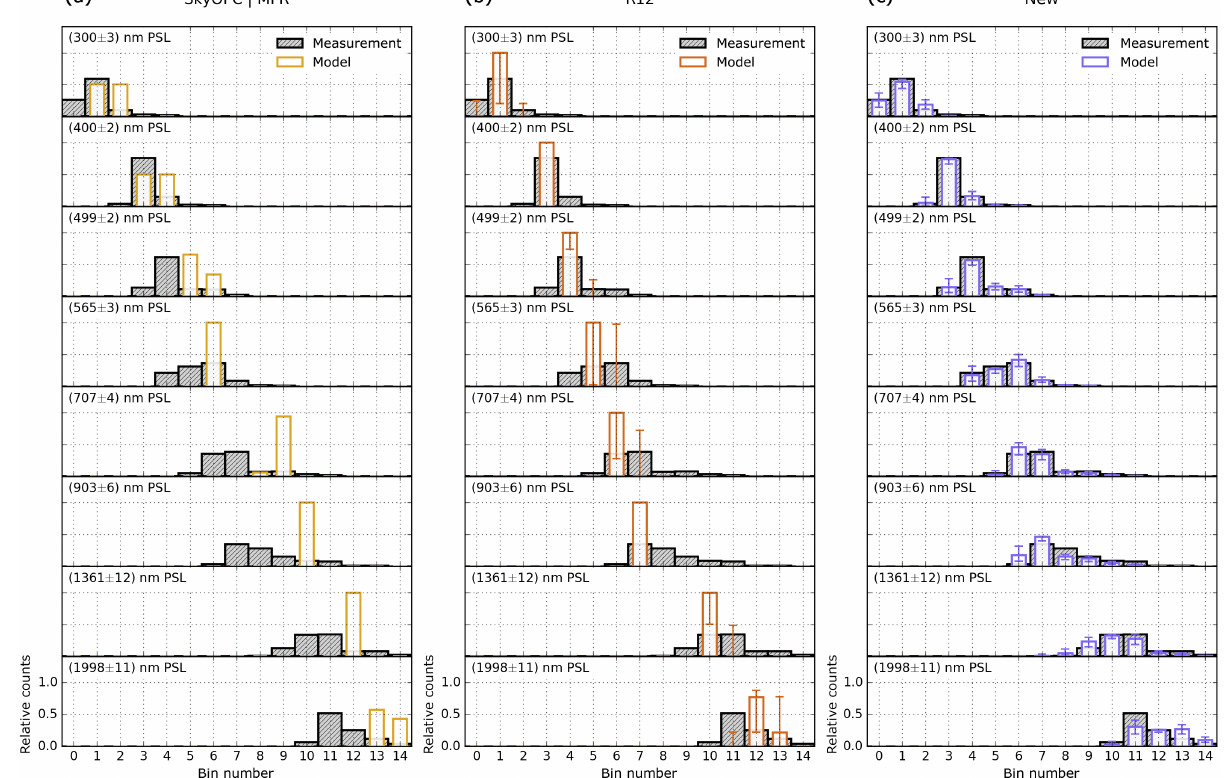
Figure 4. Comparison of modeled relative histograms (colored) and measured counterparts (gray, hatched) for the SkyOPC and different PSL particle standards (rows) for different approaches of OPC kernel function parametrization (columns). The colored histogram bars represent each model’s best estimate and the error bars are the range between the 16 and 84th percentiles of the corresponding PDFs. Panel (a) shows the theoretical instrument response according to the manufacturer-provided set of nominal diameter threshold values in gold (MFR), panel (b) the results following the calibration and instrument parametrization approach by Rosenberg et al. (2012) in red brown (R12) and panel (c) the results of the new approach in